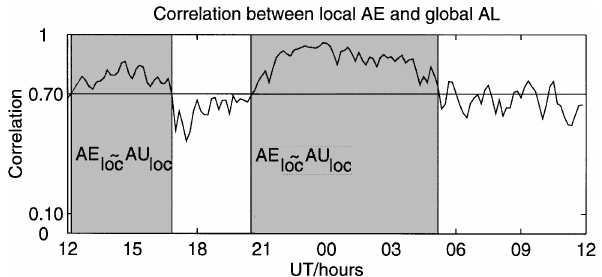
Fig. 10. Correlation between the global A ‚ and local AE when maximum 1-min local AE ’ 500 nT. The gray shadings show the UT-periods when the correlation is better than 0.7